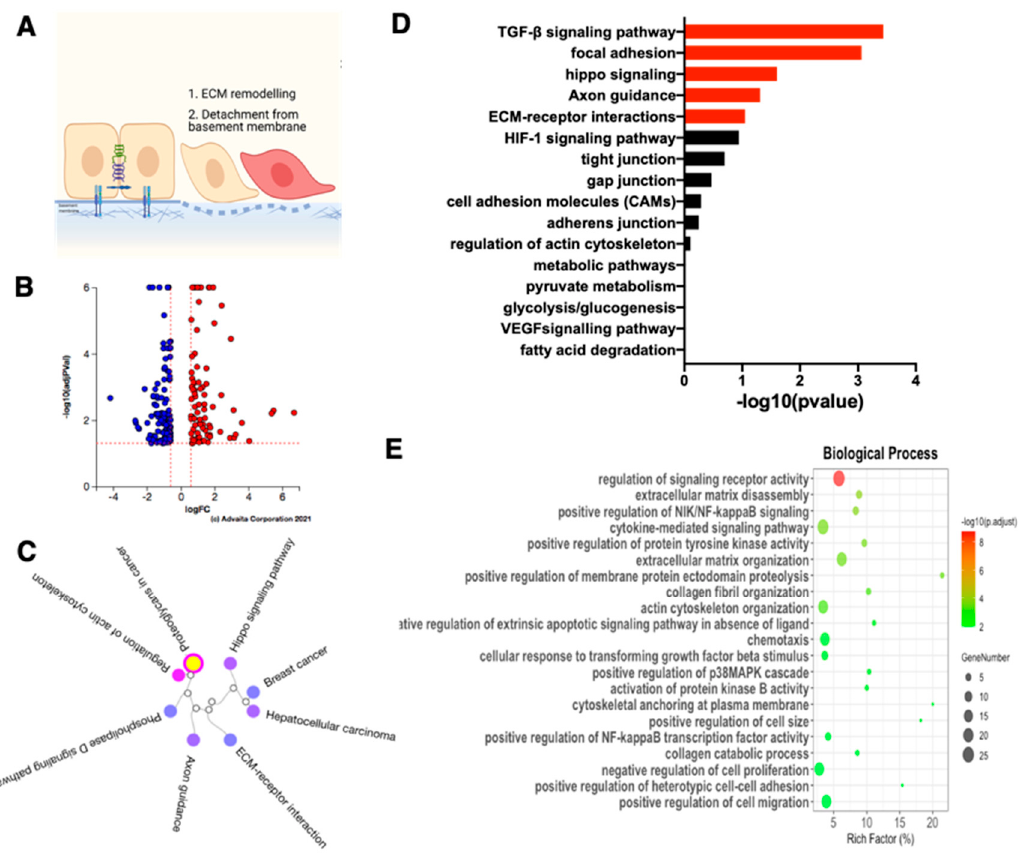
Figure 3. RNA-sequencing analysis of the E/M hybrid from the ovarian cancer cell lines. The E/M hybrid state cells of R182, R2615, and OVCAR3 were compared with their respective Estate cells in this analysis. ( A ) Proposed scheme of the first few steps in E differentiation to the E/M state including ECM remodeling and detachment from the basement membrane. ( B ) Volcano plot of differentially expressed genes (DEGs); blue dots represent downregulated DEGs, red dots represent upregulated DEGs. ( C ) Dendrogram of significant biological pathways in E/M cells compared to E cells. ( D ) Bar plot of the EMT related biological pathways in E/M compared to E cells. Significant pathways are presented as red bars, and non-significant pathways as black bars. ( E ) Top 20 GO terms for biological processes analysis in E/M when compared to the E cells.